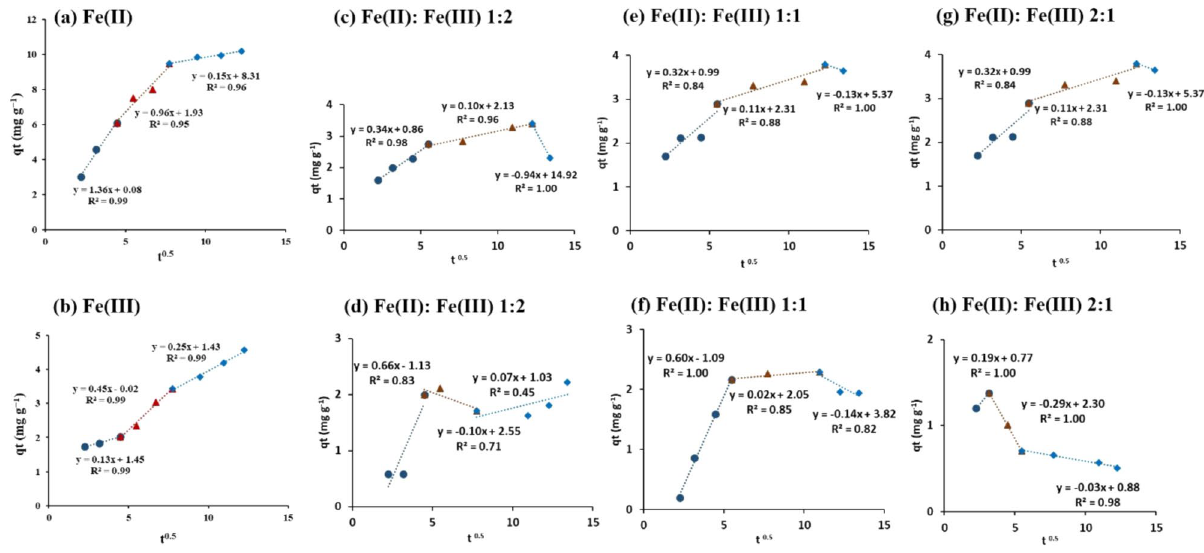
Figure 6. Intra-particle diffusion plot for the adsorption of Fe(II) and Fe(III) by cellulose nanocrystals/ graphene oxide film in single and binary